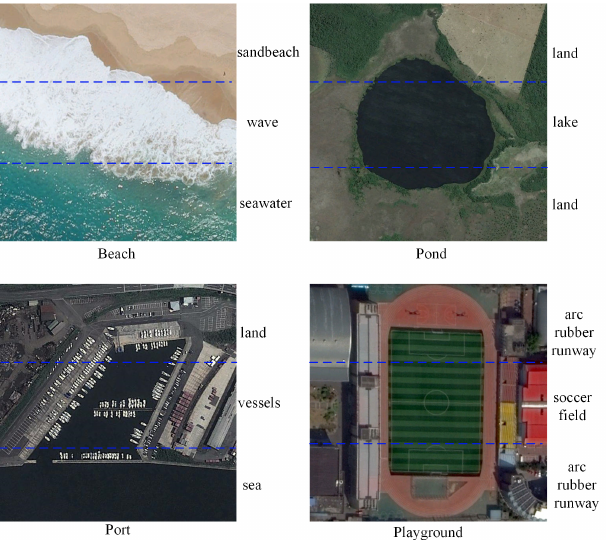
Figure 4. Three regions of different remote sensing images from the AID datasets